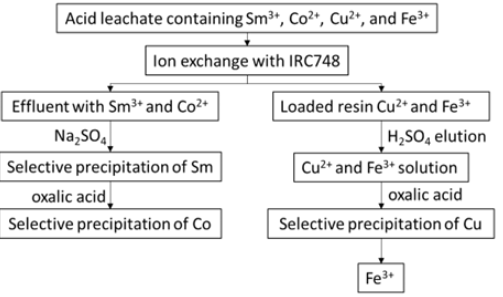
Figure 1. Proposed flowsheet for recovering Sm, Co, Fe, and Cu from SmCo 5 scrap magnets.